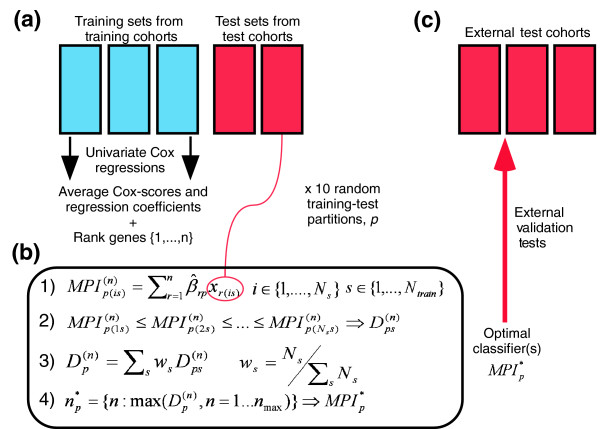
(a) For each of 10 random partitions of training cohorts into training and test sets we rank the genes according to their average Cox-scores over the Ntrain training cohorts (Ntrain = 3). (b) 1, Definition of MPI and evaluation of the optimal classifier(s) using the independent test sets of the training cohorts. 2, Dps(n)
 MathType@MTEF@5@5@+=feaafiart1ev1aaatCvAUfeBSjuyZL2yd9gzLbvyNv2Caerbhv2BYDwAHbqedmvETj2BSbqee0evGueE0jxyaibaiKI8=vI8tuQ8FMI8Gi=hEeeu0xXdbba9frFj0=OqFfea0dXdd9vqai=hGuQ8kuc9pgc9s8qqaq=dirpe0xb9q8qiLsFr0=vr0=vr0dc8meaabaqaciGacaGaaeqabaqadeqadaaakeaacaWGebWaa0baaSqaaiaadchacaWGZbaabaGaaiikaiaad6gacaGGPaaaaaaa@385C@ denotes the D-index of the top n-gene classifier for partition/realization p in test set of the training cohort s. 3, Dp(n)
 MathType@MTEF@5@5@+=feaafiart1ev1aaatCvAUfeBSjuyZL2yd9gzLbvyNv2Caerbhv2BYDwAHbqedmvETj2BSbqee0evGueE0jxyaibaiKI8=vI8tuQ8FMI8Gi=hEeeu0xXdbba9frFj0=OqFfea0dXdd9vqai=hGuQ8kuc9pgc9s8qqaq=dirpe0xb9q8qiLsFr0=vr0=vr0dc8meaabaqaciGacaGaaeqabaqadeqadaaakeaacaWGebWaa0baaSqaaiaadchaaeaacaGGOaGaamOBaiaacMcaaaaaaa@3764@ denotes the weighted average D-index over the test sets in the training cohorts where Ns denotes the size of the test set of training cohort s. 4, The optimal classifier for each partition/realization p, MPIp∗
 MathType@MTEF@5@5@+=feaafiart1ev1aaatCvAUfeBSjuyZL2yd9gzLbvyNv2Caerbhv2BYDwAHbqedmvETj2BSbqee0evGueE0jxyaibaiKI8=vI8tuQ8FMI8Gi=hEeeu0xXdbba9frFj0=OqFfea0dXdd9vqai=hGuQ8kuc9pgc9s8qqaq=dirpe0xb9q8qiLsFr0=vr0=vr0dc8meaabaqaciGacaGaaeqabaqadeqadaaakeaacaWGnbGaamiuaiaadMeadaqhaaWcbaGaamiCaaqaaiabgEHiQaaaaaa@37B3@, is defined by the number of top-ranked genes, n, that maximizes Dp(n)
 MathType@MTEF@5@5@+=feaafiart1ev1aaatCvAUfeBSjuyZL2yd9gzLbvyNv2Caerbhv2BYDwAHbqedmvETj2BSbqee0evGueE0jxyaibaiKI8=vI8tuQ8FMI8Gi=hEeeu0xXdbba9frFj0=OqFfea0dXdd9vqai=hGuQ8kuc9pgc9s8qqaq=dirpe0xb9q8qiLsFr0=vr0=vr0dc8meaabaqaciGacaGaaeqabaqadeqadaaakeaacaWGebWaa0baaSqaaiaadchaaeaacaGGOaGaamOBaiaacMcaaaaaaa@3764@. (c) Validation of the optimal classifiers MPIp∗
 MathType@MTEF@5@5@+=feaafiart1ev1aaatCvAUfeBSjuyZL2yd9gzLbvyNv2Caerbhv2BYDwAHbqedmvETj2BSbqee0evGueE0jxyaibaiKI8=vI8tuQ8FMI8Gi=hEeeu0xXdbba9frFj0=OqFfea0dXdd9vqai=hGuQ8kuc9pgc9s8qqaq=dirpe0xb9q8qiLsFr0=vr0=vr0dc8meaabaqaciGacaGaaeqabaqadeqadaaakeaacaWGnbGaamiuaiaadMeadaqhaaWcbaGaamiCaaqaaiabgEHiQaaaaaa@37B3@ in completely independent external cohorts.